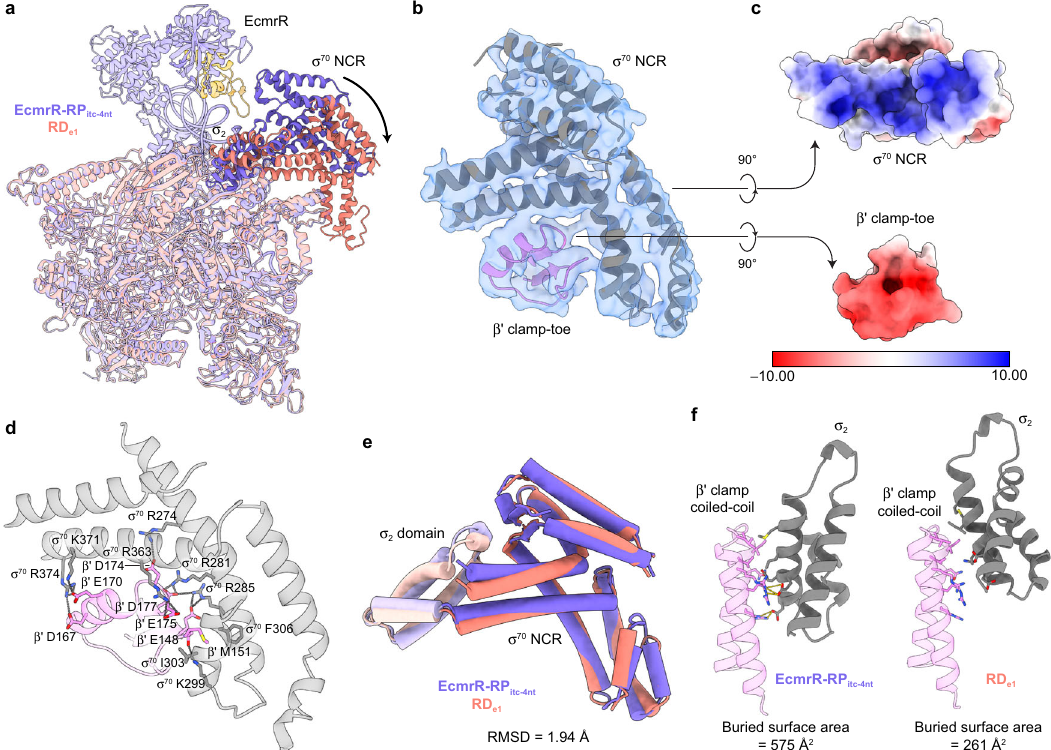
Fig. 6 σ 70 NCR adopts a different conformation and interacts with β ' clamp during promoter escape. a Superimposition of RD e1 with EcmrR-RP itc-4nt structures illustrates the large conformational changes of σ 70 NCR and σ 2 domain. The EcmrR NTD that is proximal to σ 70 NCR is colored in yellow. b A close-up view of the σ 70 NCR and β ' clamp-toe interface superimposed with the cryo-EM density (blue surface) contoured at 5.5 σ . c Electrostatic surfaces of σ 70 NCR and β ' clamp-toe. The unit of electrostatic potential is kT/e − . d Interactions between σ 70 NCR and β ' clamp-toe. Hydrogen bonds and salt bridges are shown as gray dotted lines. e Superimposition of σ 70 NCR (bright colors) together with σ 2 domain (pale colors) in RD e1 with those in EcmrR- RP itc-4nt , showing that σ 2 domain stays largely static relative to σ 70 NCR in the two structures. f Comparison of the σ 2 - β ' clamp coiled-coil interactions between the structures of EcmrR-RP itc-4nt and RD e1 . Hydrogen bonds and salt bridges are shown as yellow dotted lines. The surface areas buried between β ' clamp coiled-coil and σ 2 in the two structures are